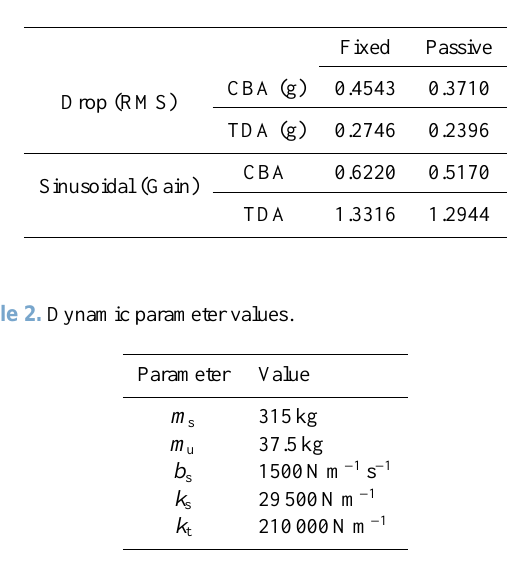
Table 1. RMS / Approximate gain values of experimental results. CBA: Car Body Acceleration. TDA: Tire Deflection Acceleration.